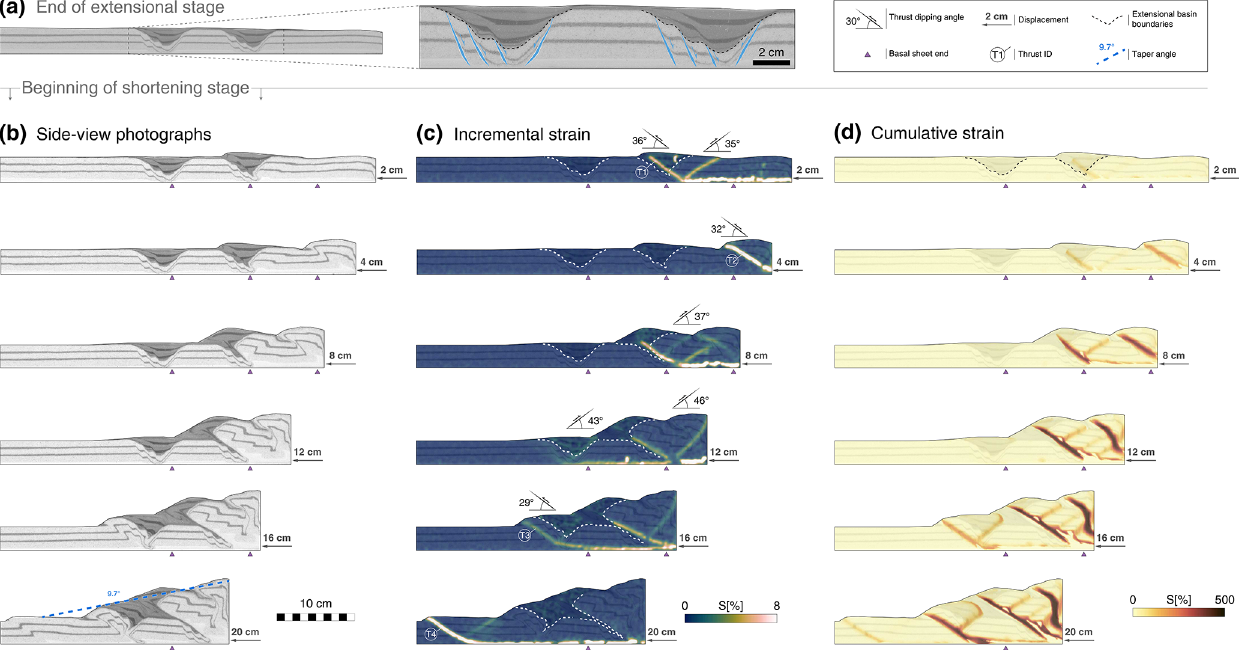
Figure 6. Experiment 2B summary. (a) Side-view photograph and interpreted close-up view at the end of the extensional stage. Shortening stage evolution, showing (b) side-view photographs, (c) incremental strain, and (d) cumulative strain.